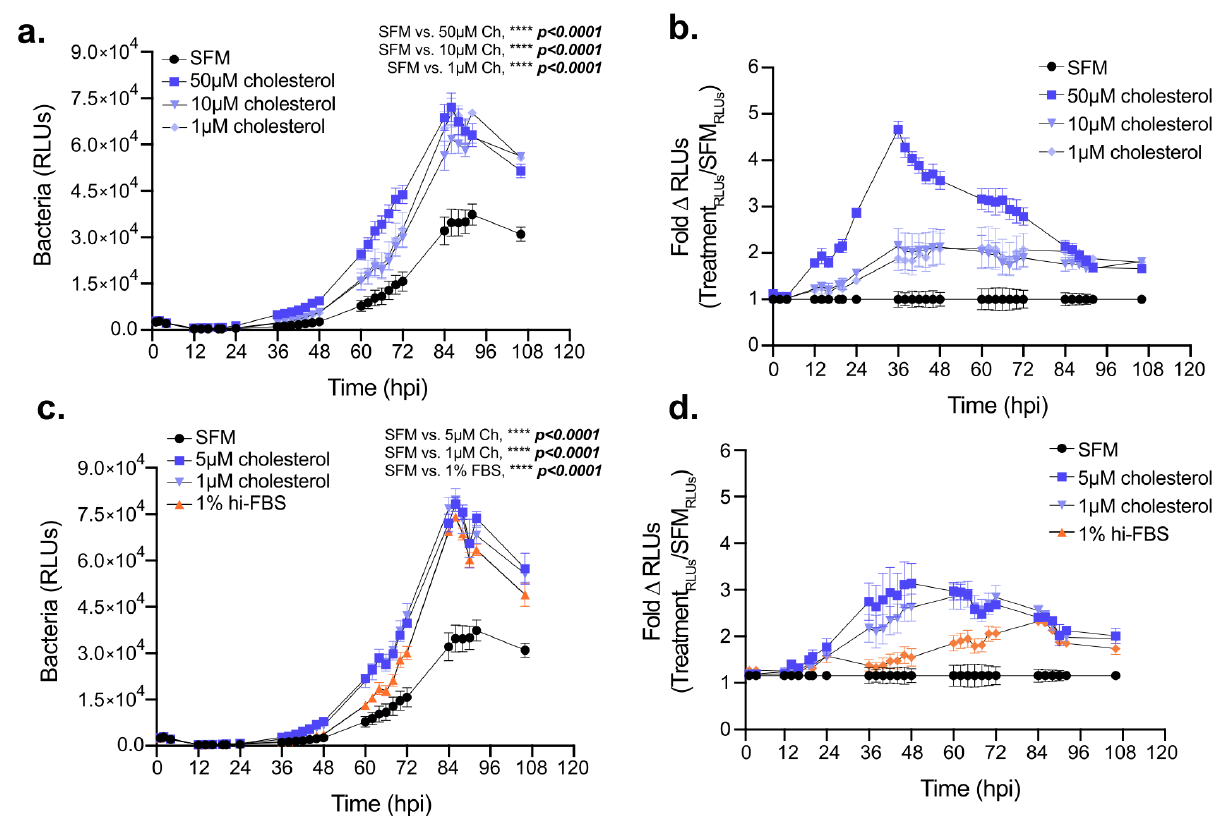
FIGURE 7: Effects of cholesterol supplementation on Lp intracellular replication. Intracellular bacterial replication measured by biolumines- cence output over 108 hrs from BMDMs infected with Lp icmRp - LuxR (MOI of 2.5). Cells were either cultured with the indicated amounts of cholesterol for 24 hrs prior to infection (a-b) and infected in serum-free media (SFM) or were treated as indicated for the duration of infec- tion starting at 2hpi (c-d) . (a and c) Luminescence output from infected BMDMs measured at the indicated times post infection. (b and d) Ratiometric analysis of Lp intracellular replication in the presence/absence of cholesterol or FBS. For each time point the ratio represents the bacteria-derived bioluminescence output produced when BMDMs were cultured under the indicated treatments divided by the output pro- duced when BMDMs were cultured in SFM. (a-d) shown are averages from technical triplicates ± SD for each time-point. **** p<0.0001, two- way ANOVA. (a-d) Representative data from one of three biological replicates are